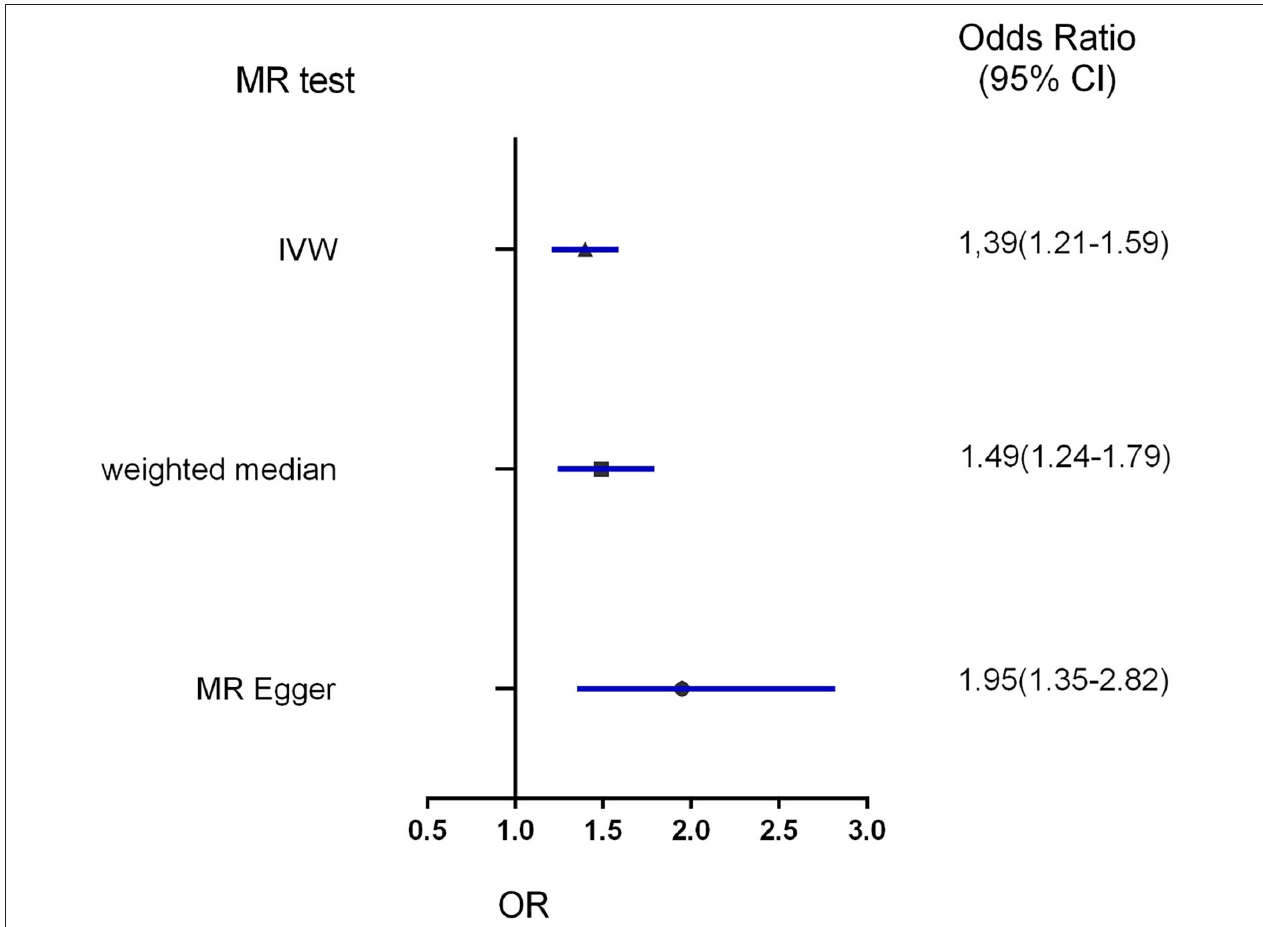
FIGURE 4 | Forest plot to visualize the causal effect of obesity on the risk of hypertension disorders in pregnancy by three methods. IVW indicates inverse-variance weighted; and MR, Mendelian